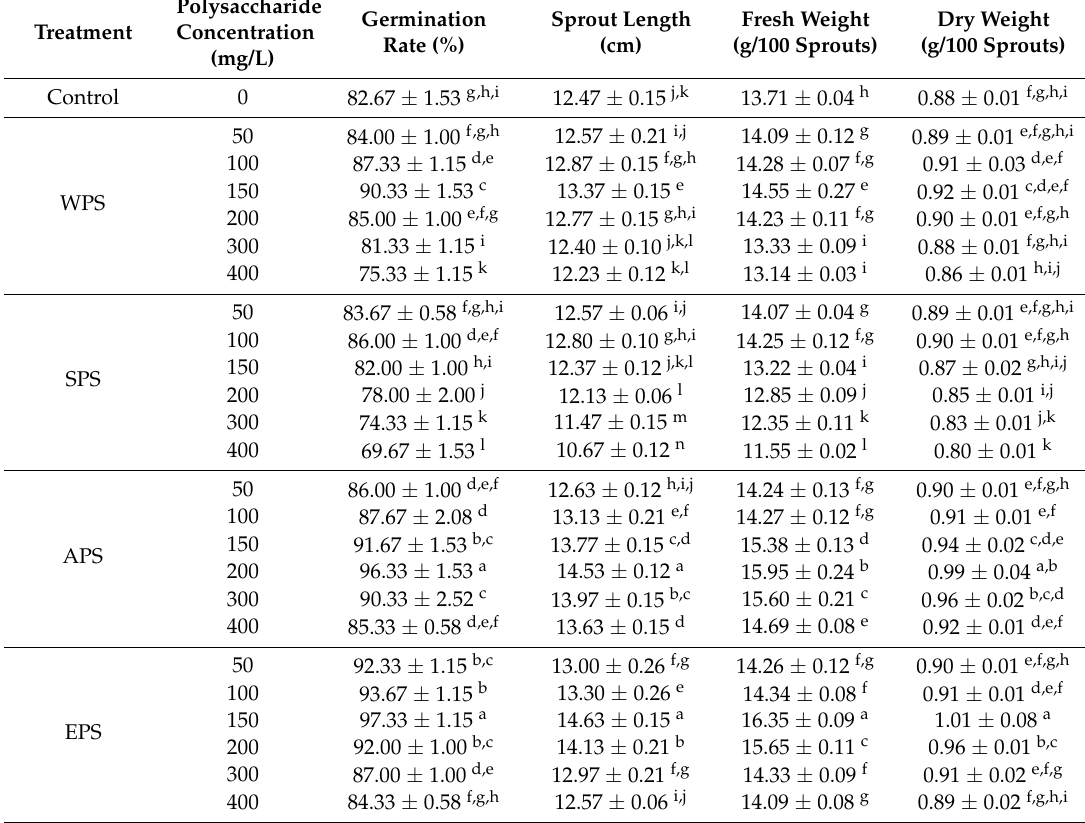
Table 1. Effects of four fungal polysaccharide elicitors WPS, SPS, APS and EPS on the sprout growth of tartary